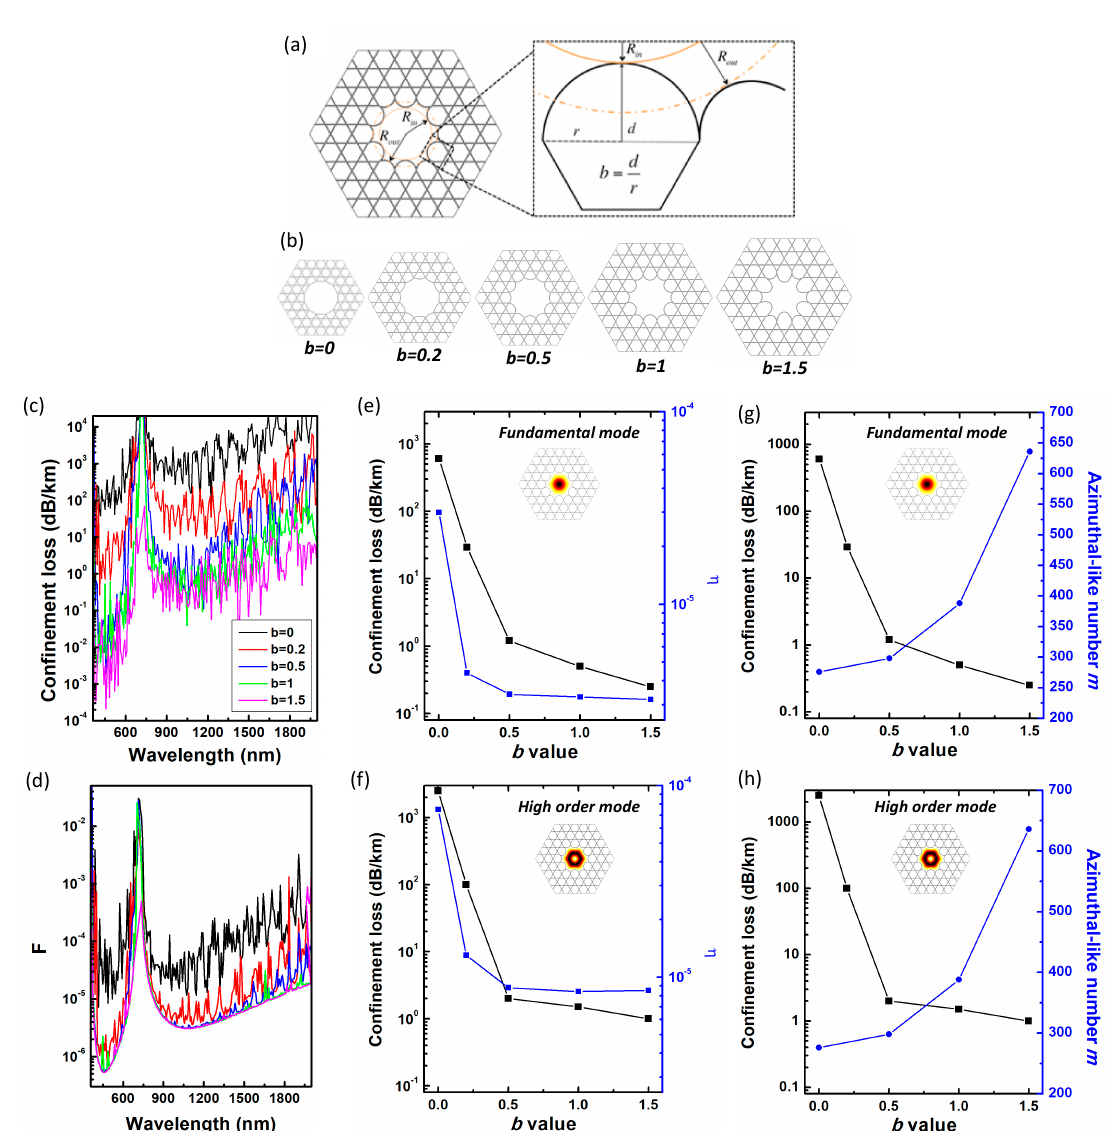
Figure 15. ( a , b ) Representation of the core contour curvature and Kagome IC HCPCF with different b . Spectra of calculated CL ( c ) and optical overlap with silica coefficient η ( d ) of Kagome HCPCF with the different b parameter (reprinted with permission from Reference [63], OSA, 2013). Evolution with b parameter of the CL and the optical overlap with silica coefficient η at 1030 nm for HE 11 fundamental core mode ( e ) and for the lowest-loss higher order mode ( f ). Evolution with b parameter of the CL and m evolution at 1030 nm for HE 11 fundamental core mode ( g ) and for the lowest-loss higher order mode ( h ).